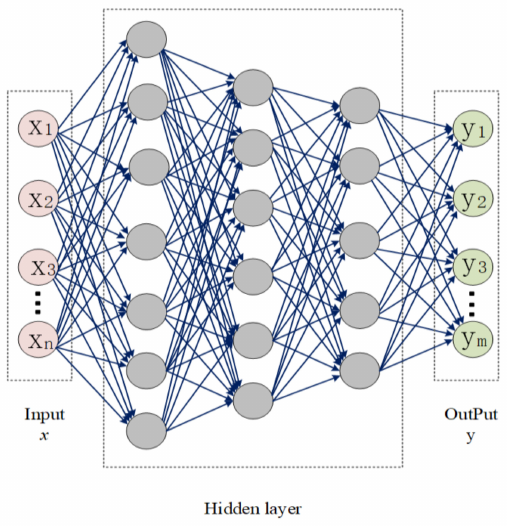
Figure 6. The structure of the fully connected